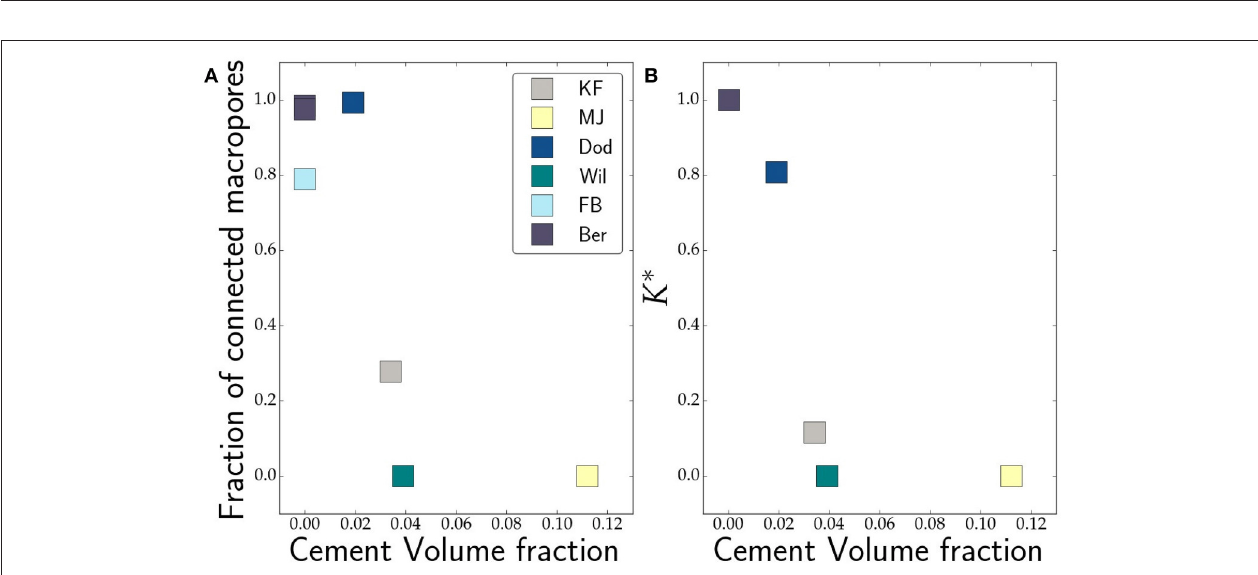
FIGURE 9 | Plots of fraction of (A) interconnected macroporosity and (B) the ratio between macro permeability and total permeability as a function of cement volume fraction.